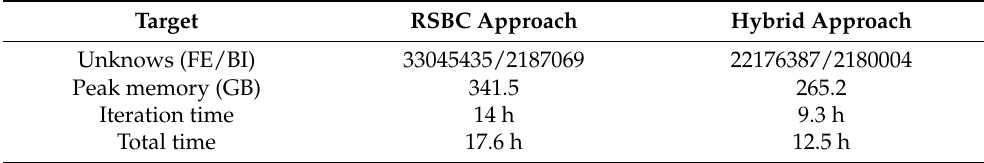
Table 1. Computational statistics of the UVA scale